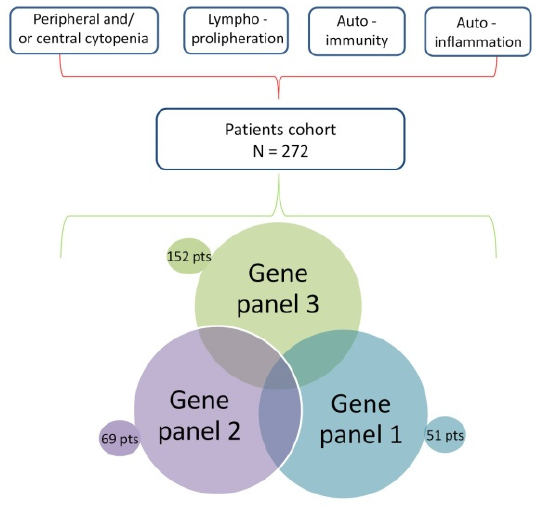
Figure 1. Breakdown of a total of 272 patients with unclassified cytopenias (either central or peripheral), immune dysregulation, autoimmunity, and autoinflammation that underwent genetic tests at the Gaslini Institute from 2015 to 2019, through the three consecutive overlapping gene panels shown at the bottom.